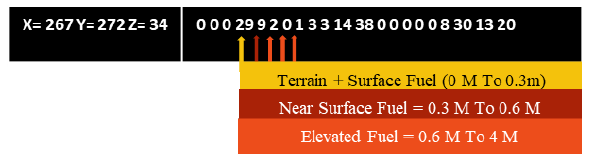
Figure 10: A sample of point clouds in a column in the voxel space at coordinate x = 267, y= 272 & z= 34